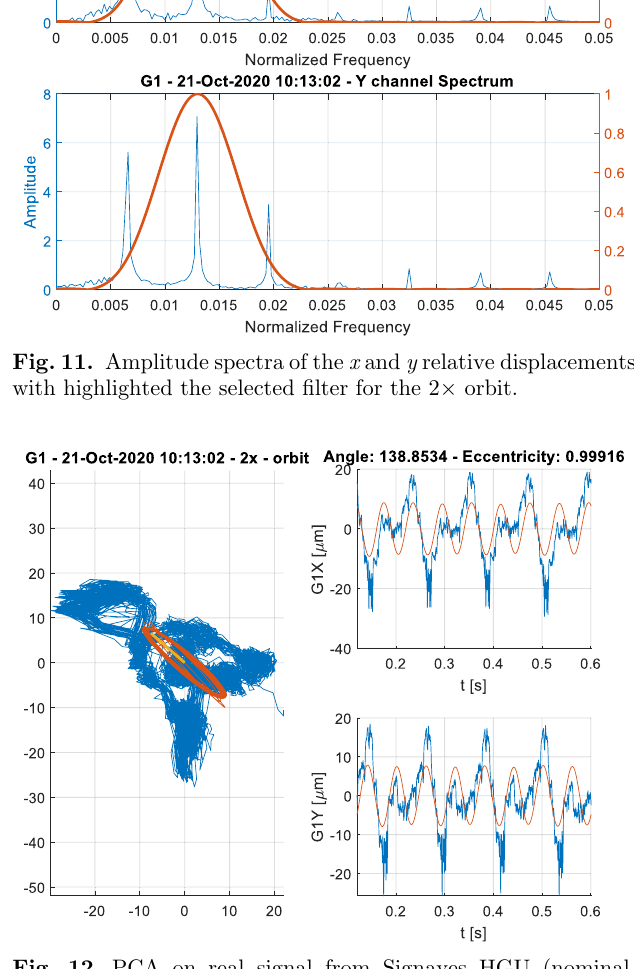
Fig. 12. PCA on real signal from Signayes HGU (nominal, regimated condition) fi ltered around the second order. The 2 (cid:4) orbit is visualized in red and features an eccentricity of almost 1. The major semi-axis (i.e., the fi rst principal component) is represented in yellow and is inclined of 138.9 ° .